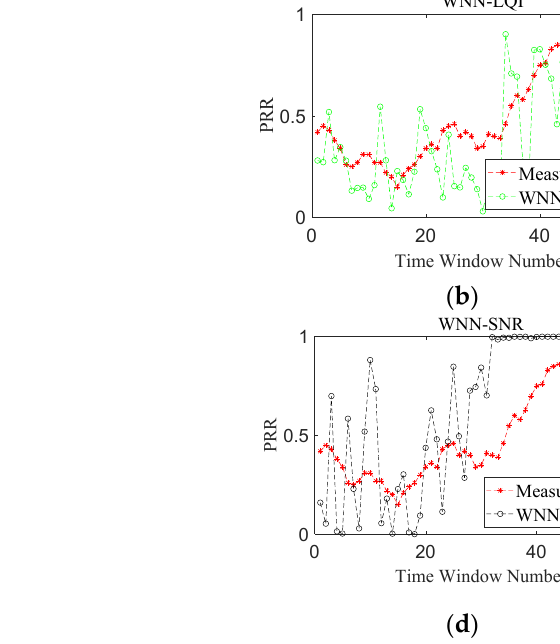
Figure 10. Performance comparison under sudden changed links. ( a ) RNN-LQI, ( b ) WNN-LQI, ( c ) RNN-SNR, ( d ) WNN-SNR.